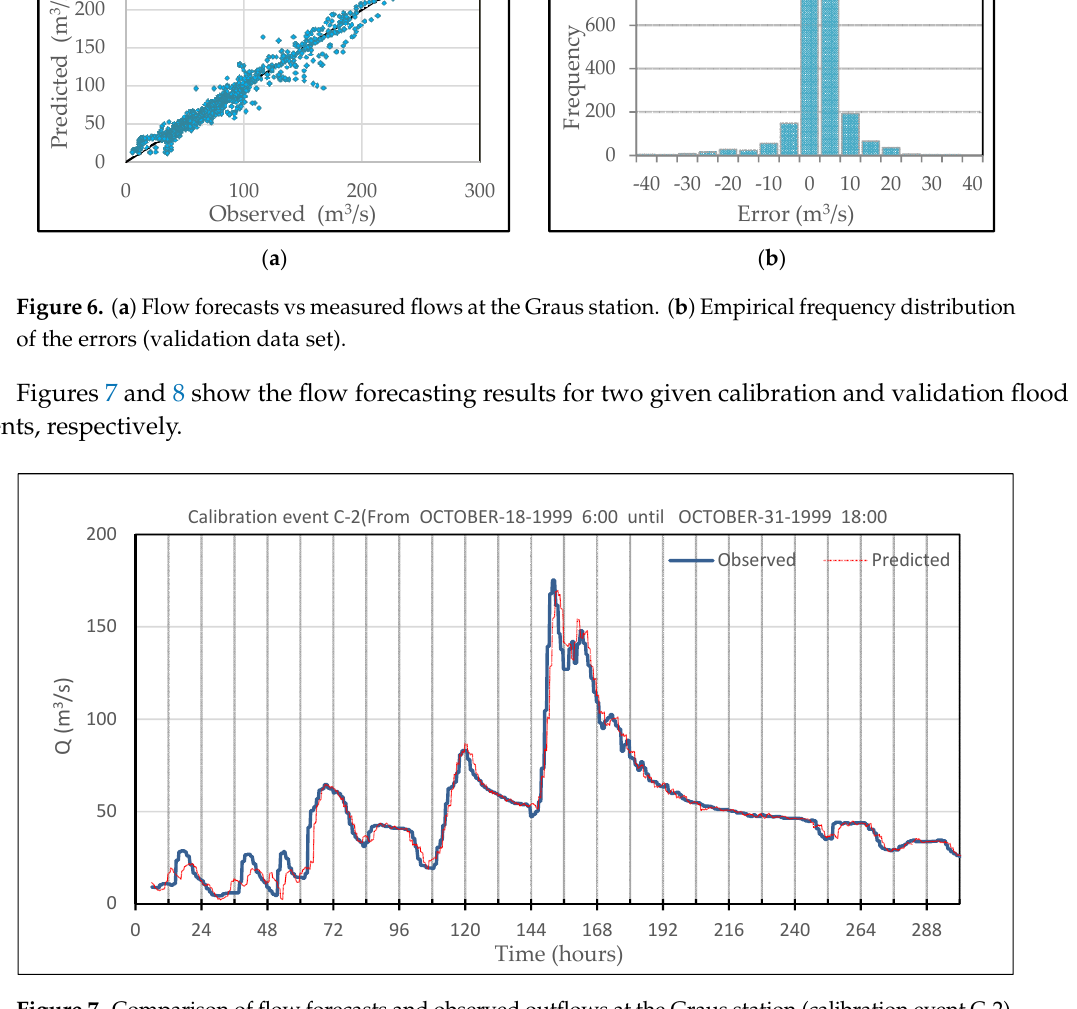
Figure 7. Comparison of flow forecasts and observed outflows at the Graus station (calibration event C-2).